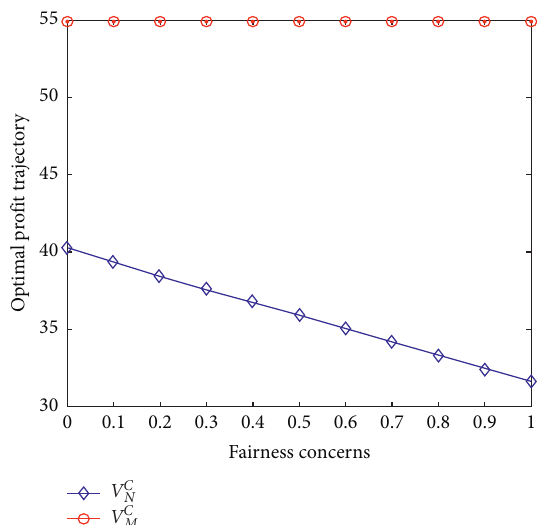
Figure 2: Profit trend chart under fairness concerns.